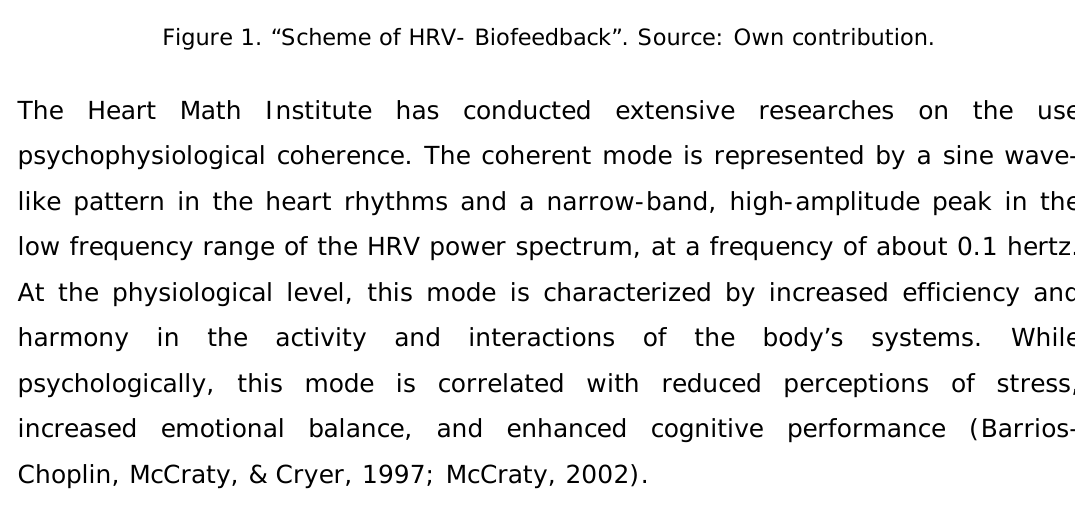
Figure 1. “Scheme of HRV- Biofeedback”. Source: Own